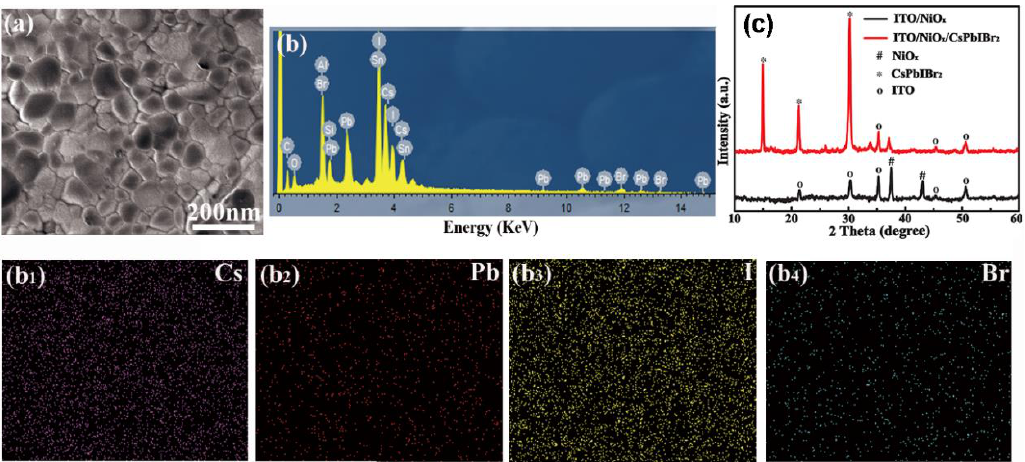
Figure 2. ( a ) Top view scanning electron micrograph (SEM) of CsPbIBr 2 film. ( b ) The EDS spectra. ( c ) X-ray di ff raction (XRD) of ITO / NiO x and ITO / NiO x / CsPbIBr 2 . ( b 1–4 ) The EDS elemental mappings of Cs, Pb, I and Br throughout CsPbIBr 2 film.